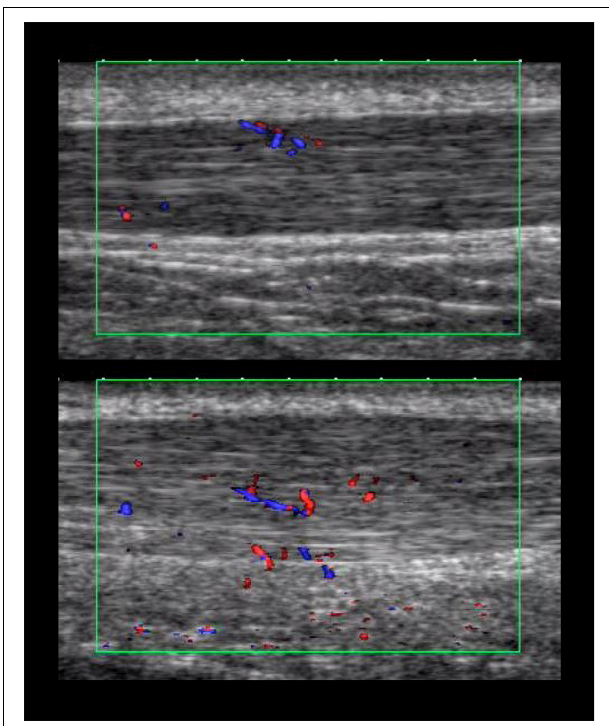
FIGURE 2 | Momentary images from intratendinous blood flow (IBF) video sequences of an asymptomatic (top) and symptomatic (bottom) Achilles tendon.